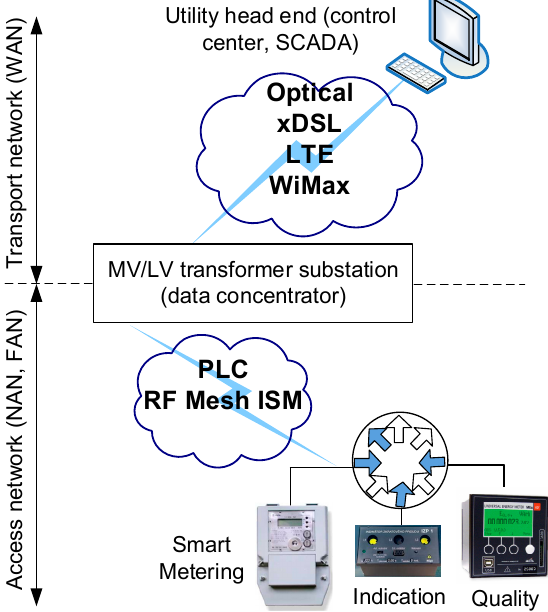
Figure 1. Smart Metering communication network architecture with several technologies.